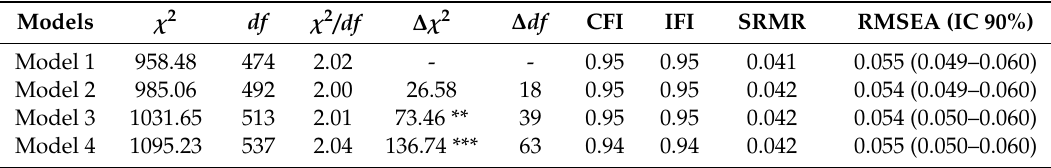
Table 1. Gender Invariance Analysis.